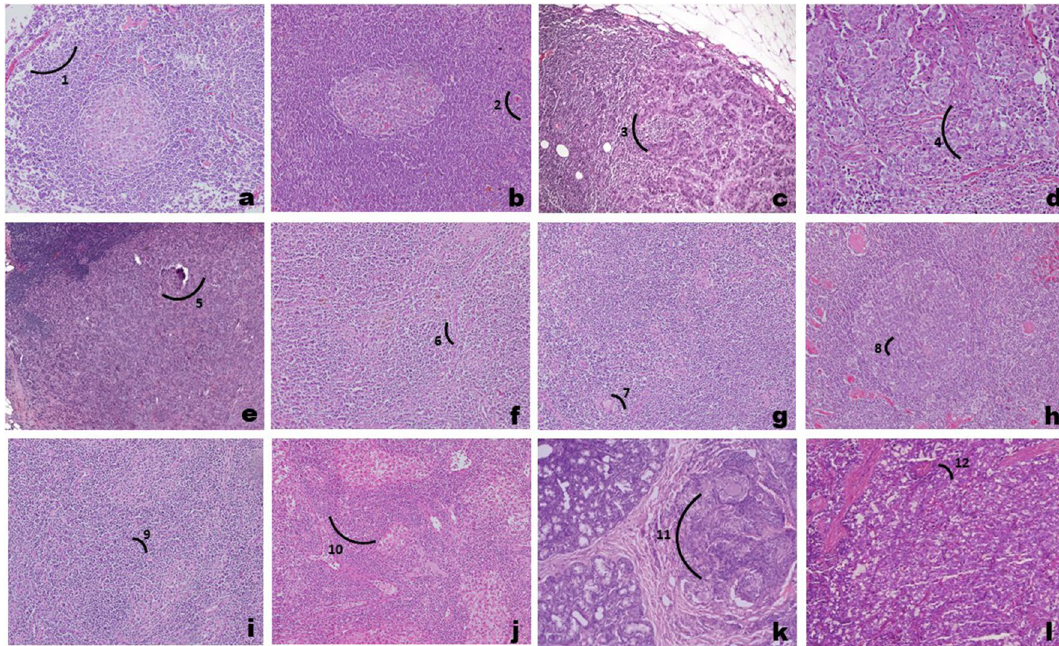
Figure 3. Photomicrographs showing sentinel lymph node with metastasis ( a – e ), sentinel lymph node without metastasis ( f – j ), and benign breast tumor tissue ( k , l ) in hematoxylin and eosin stained sections under light microscopy. (1) complete effacement of architecture by a metastatic cancer cells; (2) infilteration by a metastatic cancer cells; (3) presence of tumor cell nests in the sub-capsular area with a part of the lymph node seen at one edge; (4) presence of large area of tumor cell nest replacing the normal lymph node parenchyma; (5) complete effacement of architecture by metastatic cancer cells. (6–10) shows prominent reactive centre without any evidence of tumor cells in the lymph node parenchyma and depicts paracortical expansion with vascular proliferation indicative of reactive lymphadenopathy. (11–12) depicts benign breast lesion consisting of terminal duct lobular units with bi-layered epithelium and a slant inter venium